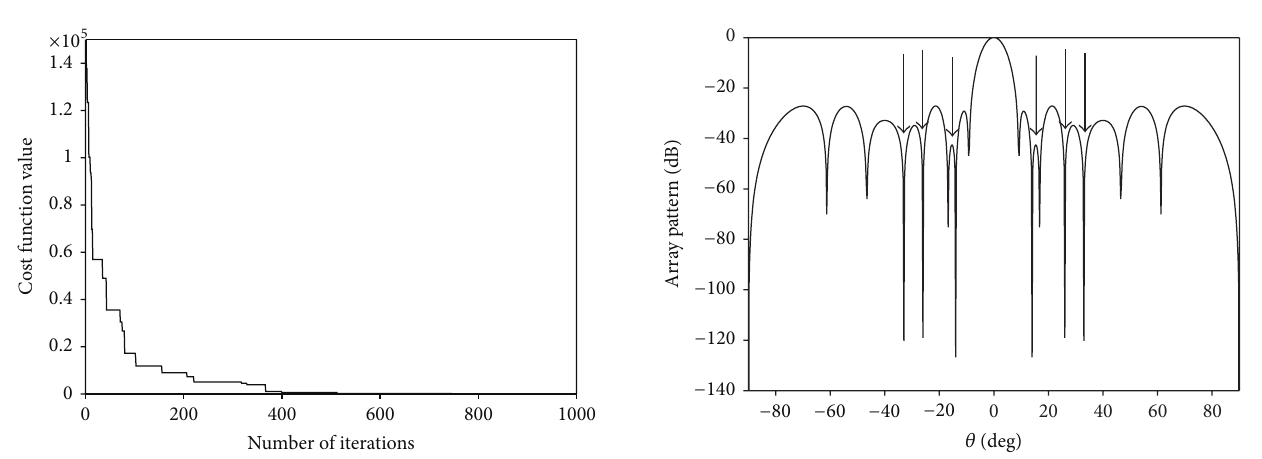
Figure 4: Convergence curve of the nulling pattern achieved by the BSA.